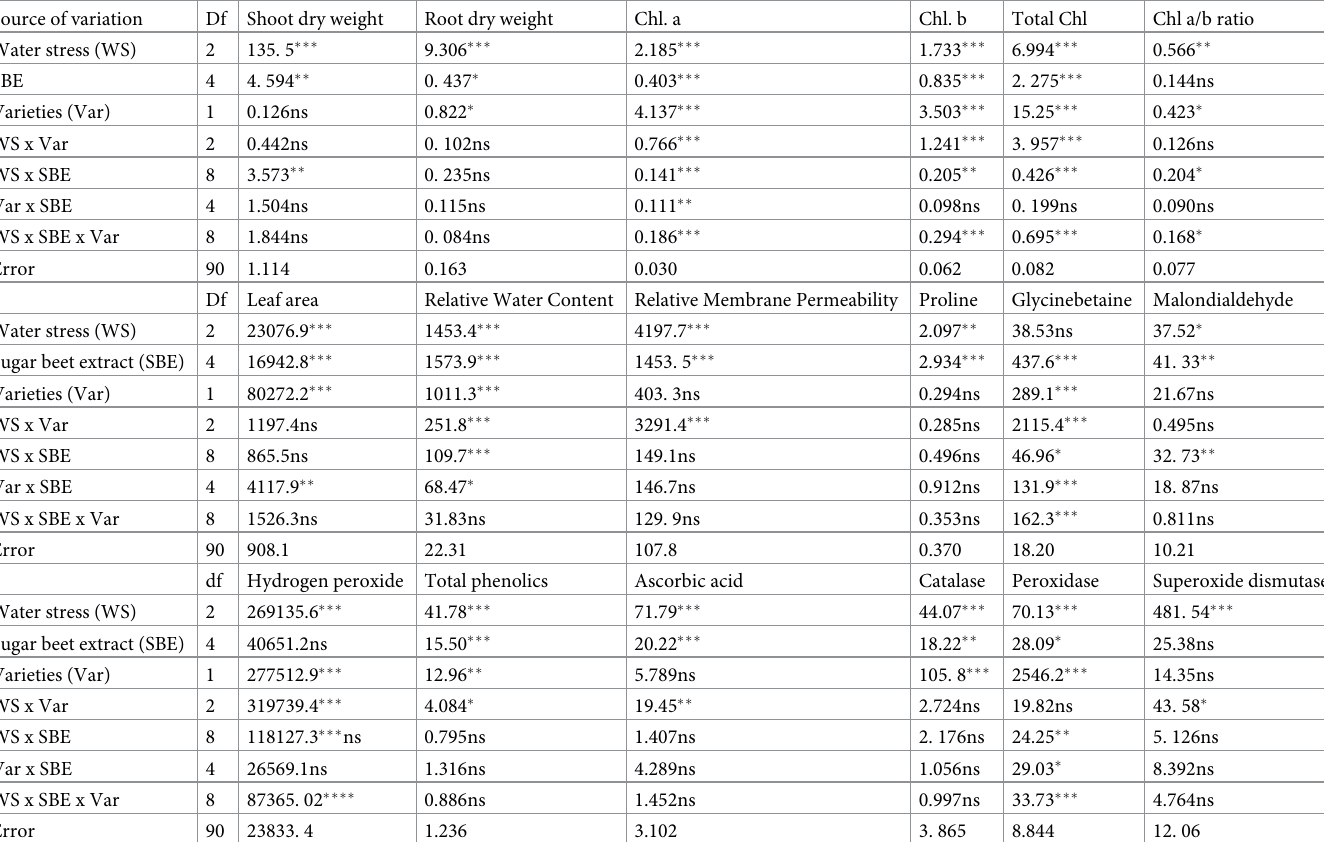
Table 1. Three-way ANOVA of data for morphological and biochemical variables of water stressed plants of two maize varieties subjected to varying (1%, 2%, 3% & 4%) levels of sugar beet extract (SBE). Source of variation